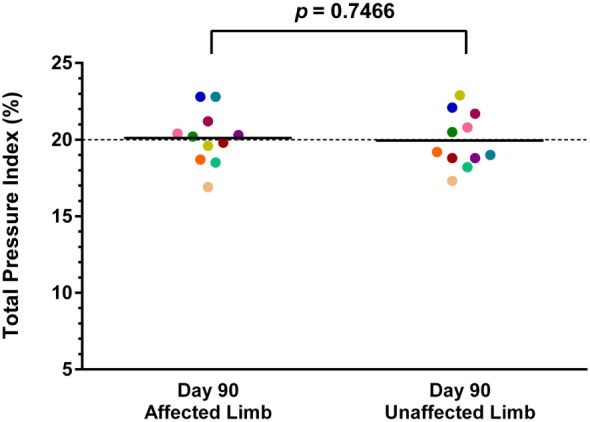
No significant difference was found between the treated limb and contralateral limb total pressure index percent (TPI%) at day 90 (p = 0.7466) (solid line, mean; dotted line, normal TPI%).